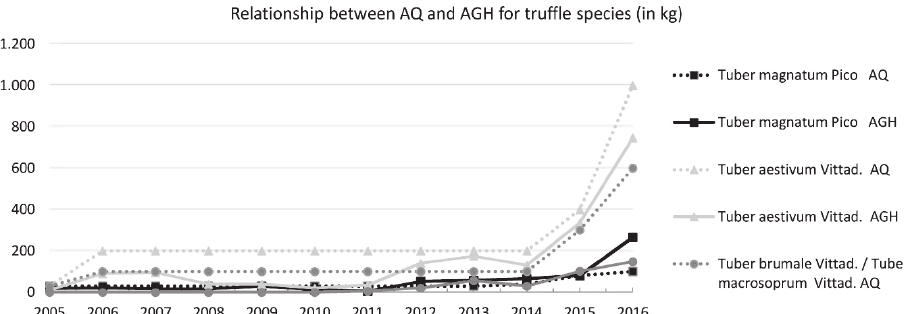
Figure 5. The estimation and demand of truffles trade in Serbia. AQ and AGH according to INCS for truffle